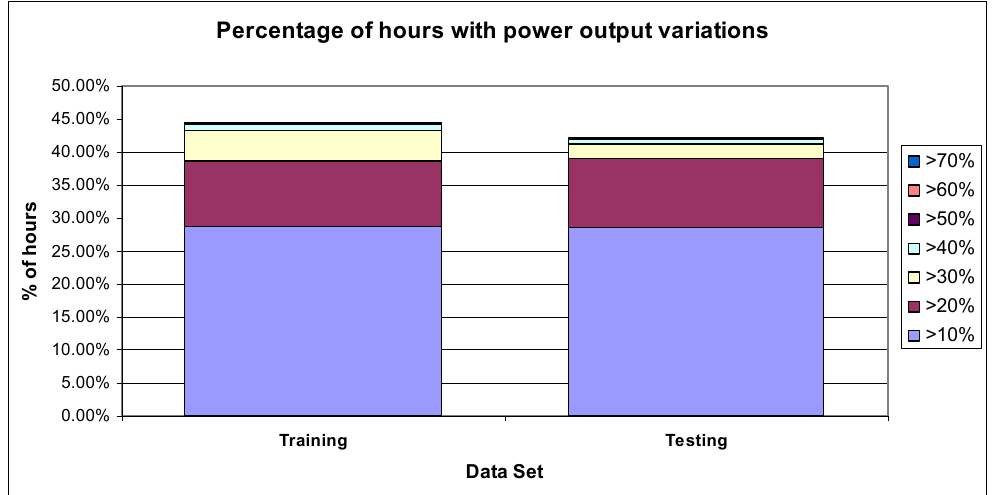
Figure 4. Percentage of hours with power output variations with respect to power rating of the PV plant, for the data sets of training and